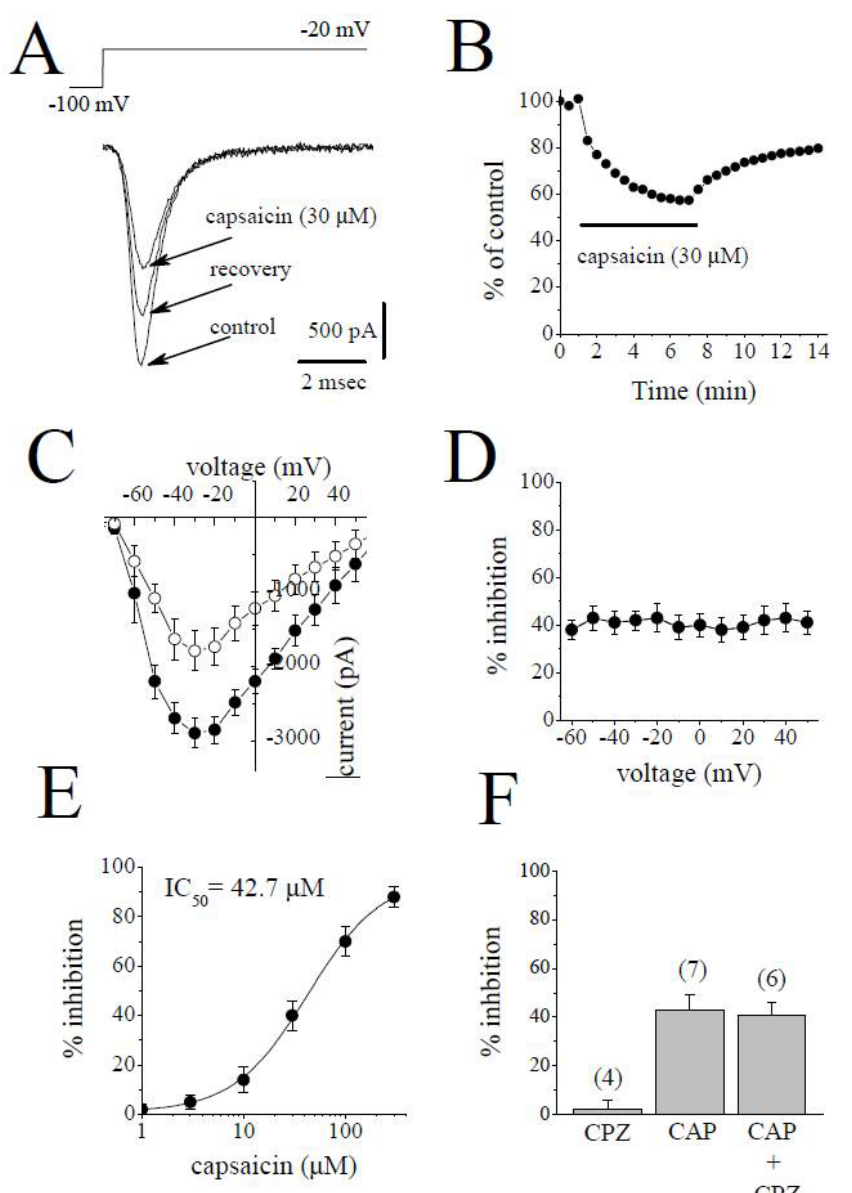
Figure 1. Capsaicin inhibits I Na in rabbit ventricular myocytes. ( A ) Superimposed current traces in control conditions, 6 min after exposure to 30 µM capsaicin, and 8 min recovery. The pulse protocol to activate I Na is shown as in inset. ( B ) Time course of the effect of capsaicin on the maximal ampli- tudes of I Na as % of control current calculated as the mean of three consecutive control currents at the beginning of the experiment. ( C ) Current–voltage relationship of I Na in the absence and presence of 30 µM capsaicin are presented with filled and open circles, respectively ( n = 5). ( D ) Relationship between the extent of capsaicin (30 µM) inhibition of I Na and test potential ( n = 5; p > 0.05, ANOVA). ( E ) Concentration-inhibition curve for capsaicin inhibition of I Na ( n = 4–7). ( F ) The effect of capsaze- pine (3 µM) and the extent of capsaicin (30 µM) inhibition of I Na in the absence and presence of 3 µM capsazepine. The number of cells tested for each group was presented on top of each bar ( p > 0.05; t -test).